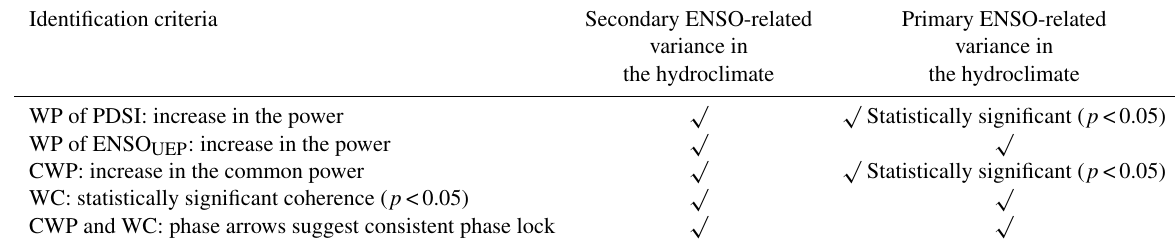
Table 2. The identification criteria for periods with ENSO-related variance in March–May hydroclimate. Two types of variance periods were identified from unified ENSO proxy and PDSI proxy data: primary ENSO-related variance and secondary ENSO-related variance in the hydroclimate. These periods were defined according to regions in wavelet power spectrum (WP), cross-wavelet power (CWP), and coherence spectrum (WC) that were overlapping in time-frequency space and fulfilled the criteria in the table. Variance period refers to period when ENSO had increased influence on the March–May hydroclimate in mainland Southeast Asia. Identification criteria Secondary ENSO-related Primary ENSO-related variance in variance in the hydroclimate the